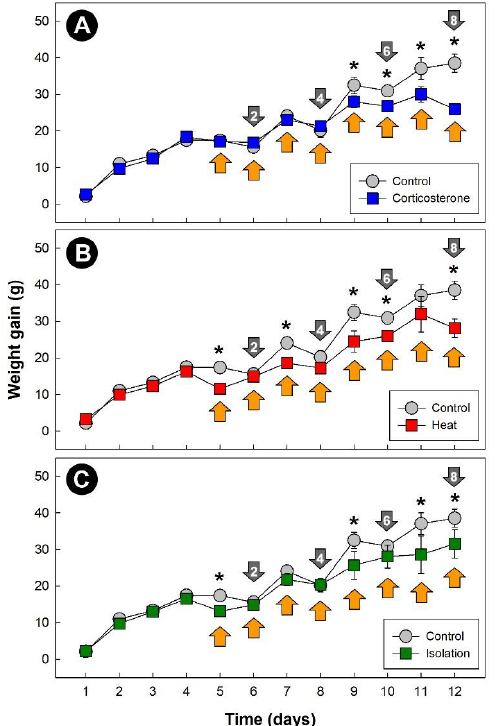
Figure 1. Daily weight gain of chicks (g). ( A ) Corticosterone treatment; ( B ) heat treatment (8 h at 36 °C per day); and ( C ) isolation treatment (1 h of isolation per day). Grey markers are control treatment birds. Markers indicated with an asterisk indicate a difference with the control treatment birds at individual time points ( p ≤ 0.050). Orange arrows denote the stress exposure period, and grey arrows signify endpoints, with the number within the arrows denoting cumulative stress events. Vertical lines associated with markers are standard errors of the mean (SEM), and for instances where no vertical line is shown, the SEM was within the marker.